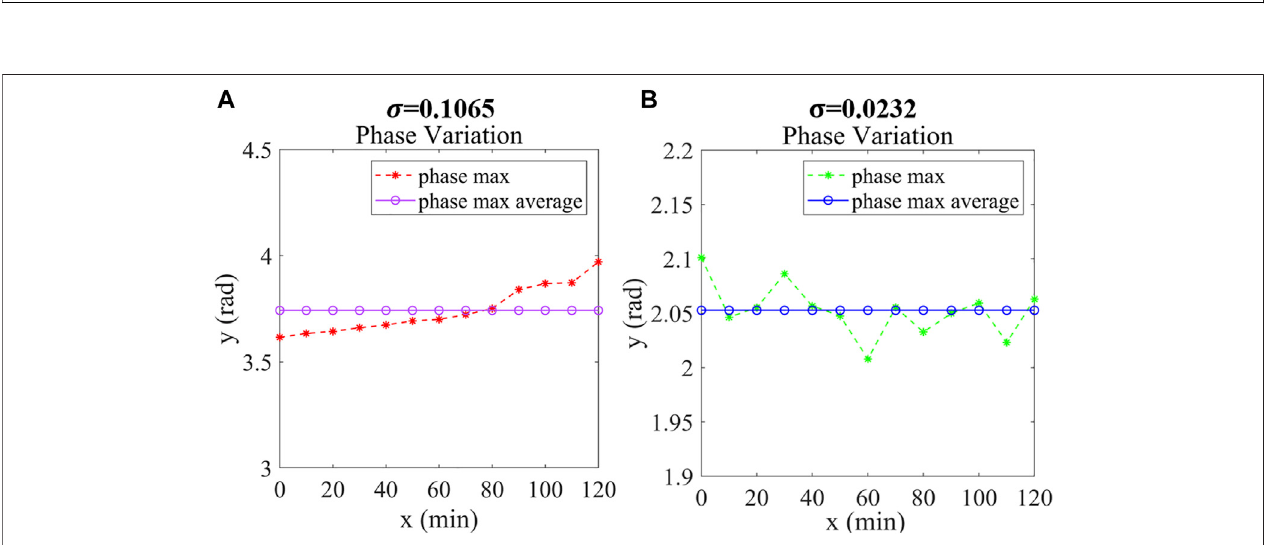
Frontiers in Physics |